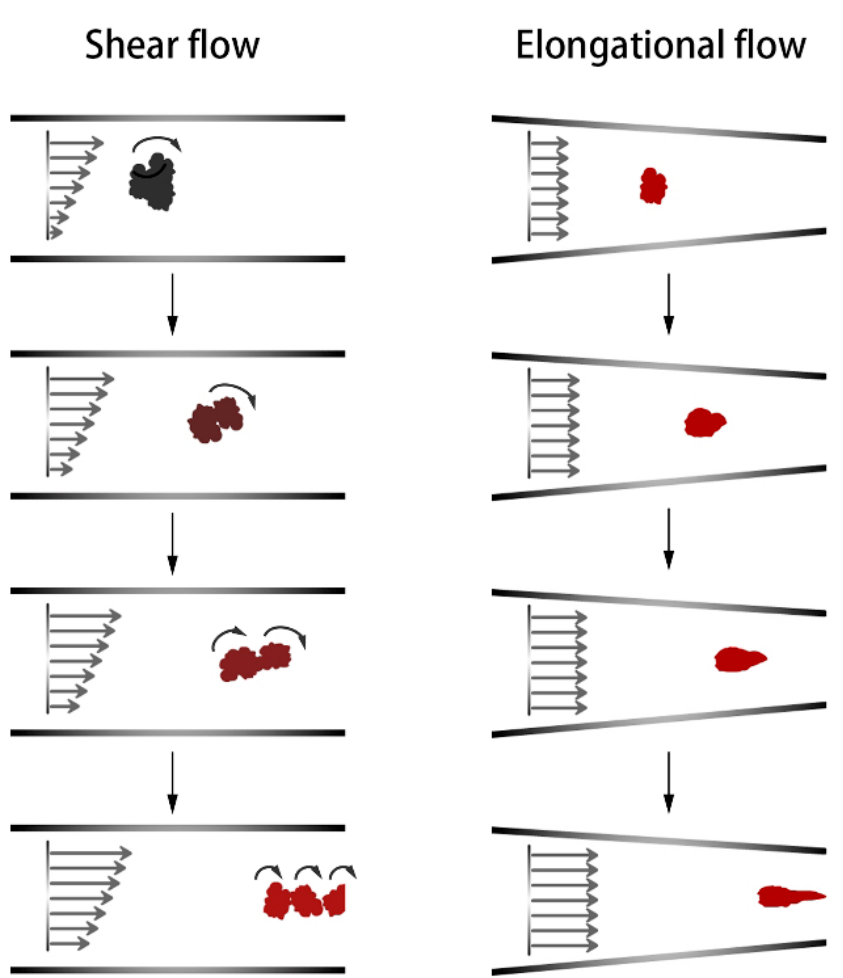
Figure 7. Result of Payne effect measurements. ( a ) The "G’-strain" curve of S1-S8, and ( b ) G’ difference and rate of decline of S1–S8.